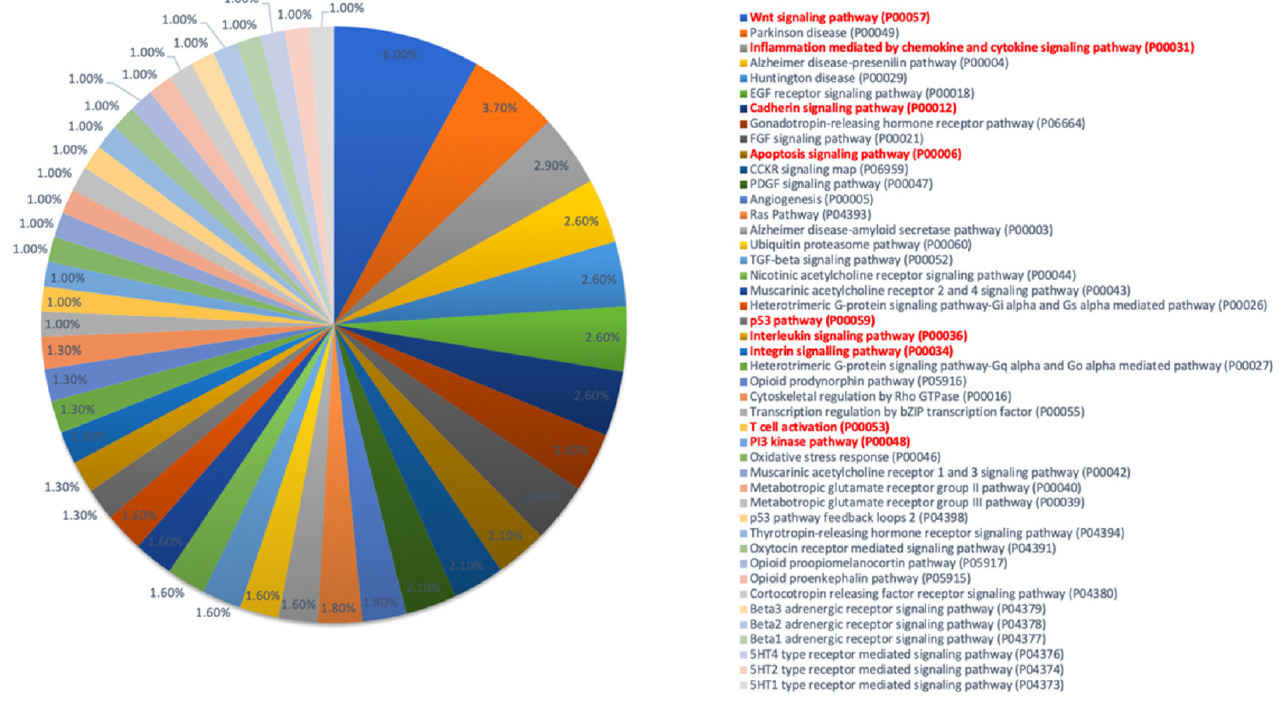
Figure 7. Gene Ontology pathway enrichment analysis in co ‐ infected CEM CCR5+ cells. List of path ‐ ways downregulated in CEM CCR5+ cells infected with HSV ‐ 2 and HIV ‐ 1 based on gene enrichment analysis with a p < 0.05 and FDR < 0.05.